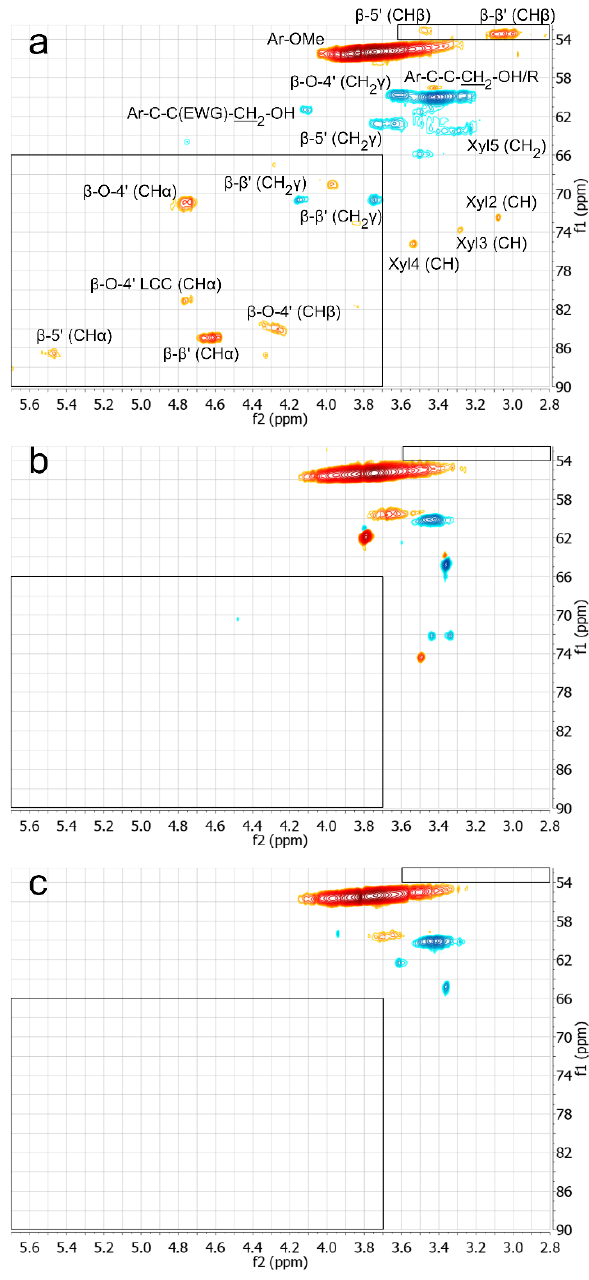
Figure 3. Inter-unit aliphatic region δ C / δ H 52–90/2.8–5.7ppm of heteronuclear single quantum coherence spectroscopy (HSQC) spectra of the LignoBoost lignin ( a ), char ( b ) and precipitated solids ( c ). Notable inter-unit linkages and carbohydrate connections are marked with black squares [20]. EWG : electron withdrawing group. Xyl : xylan, with the corresponding carbon number. LCC: lignin–carbohydrate complex.